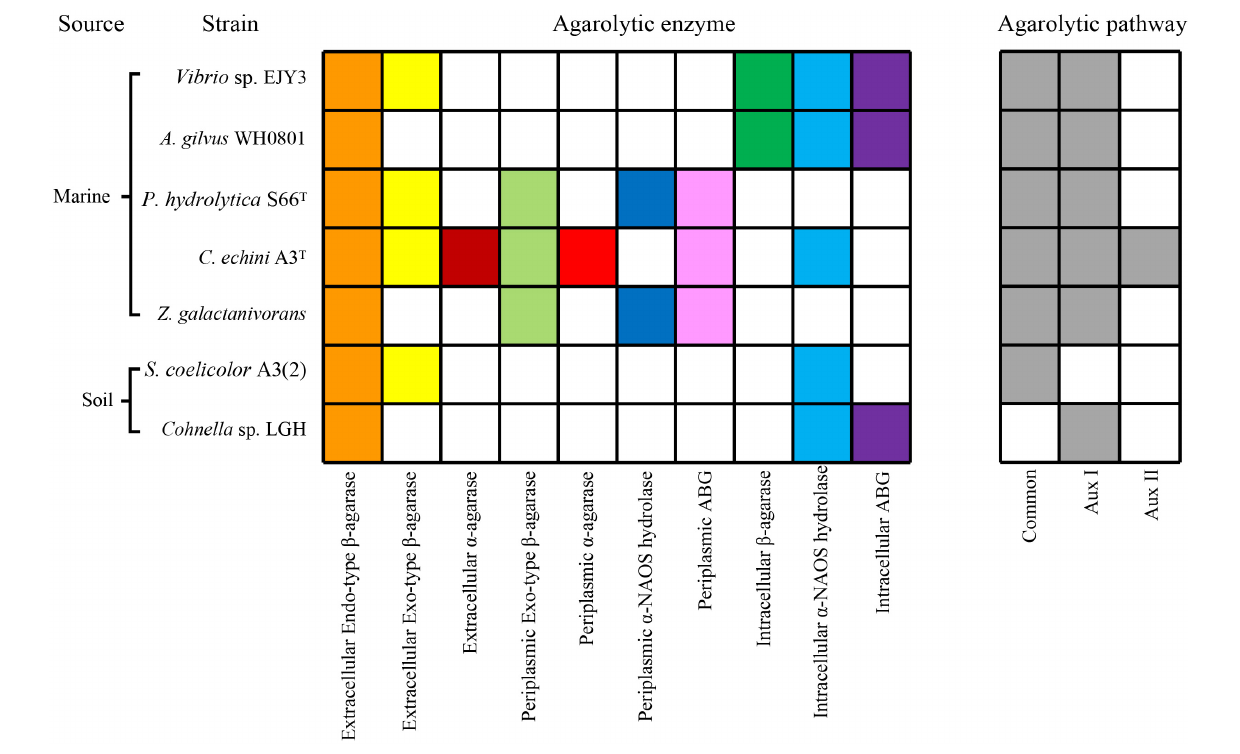
FIGURE 6 | Comparative analysis of characterized agarolytic pathway in bacteria. Colored boxes indicated that bacteria harbored agarolytic enzyme or agarolytic pathway, white boxes indicated that agarolytic enzyme or agarolytic pathway were absent in